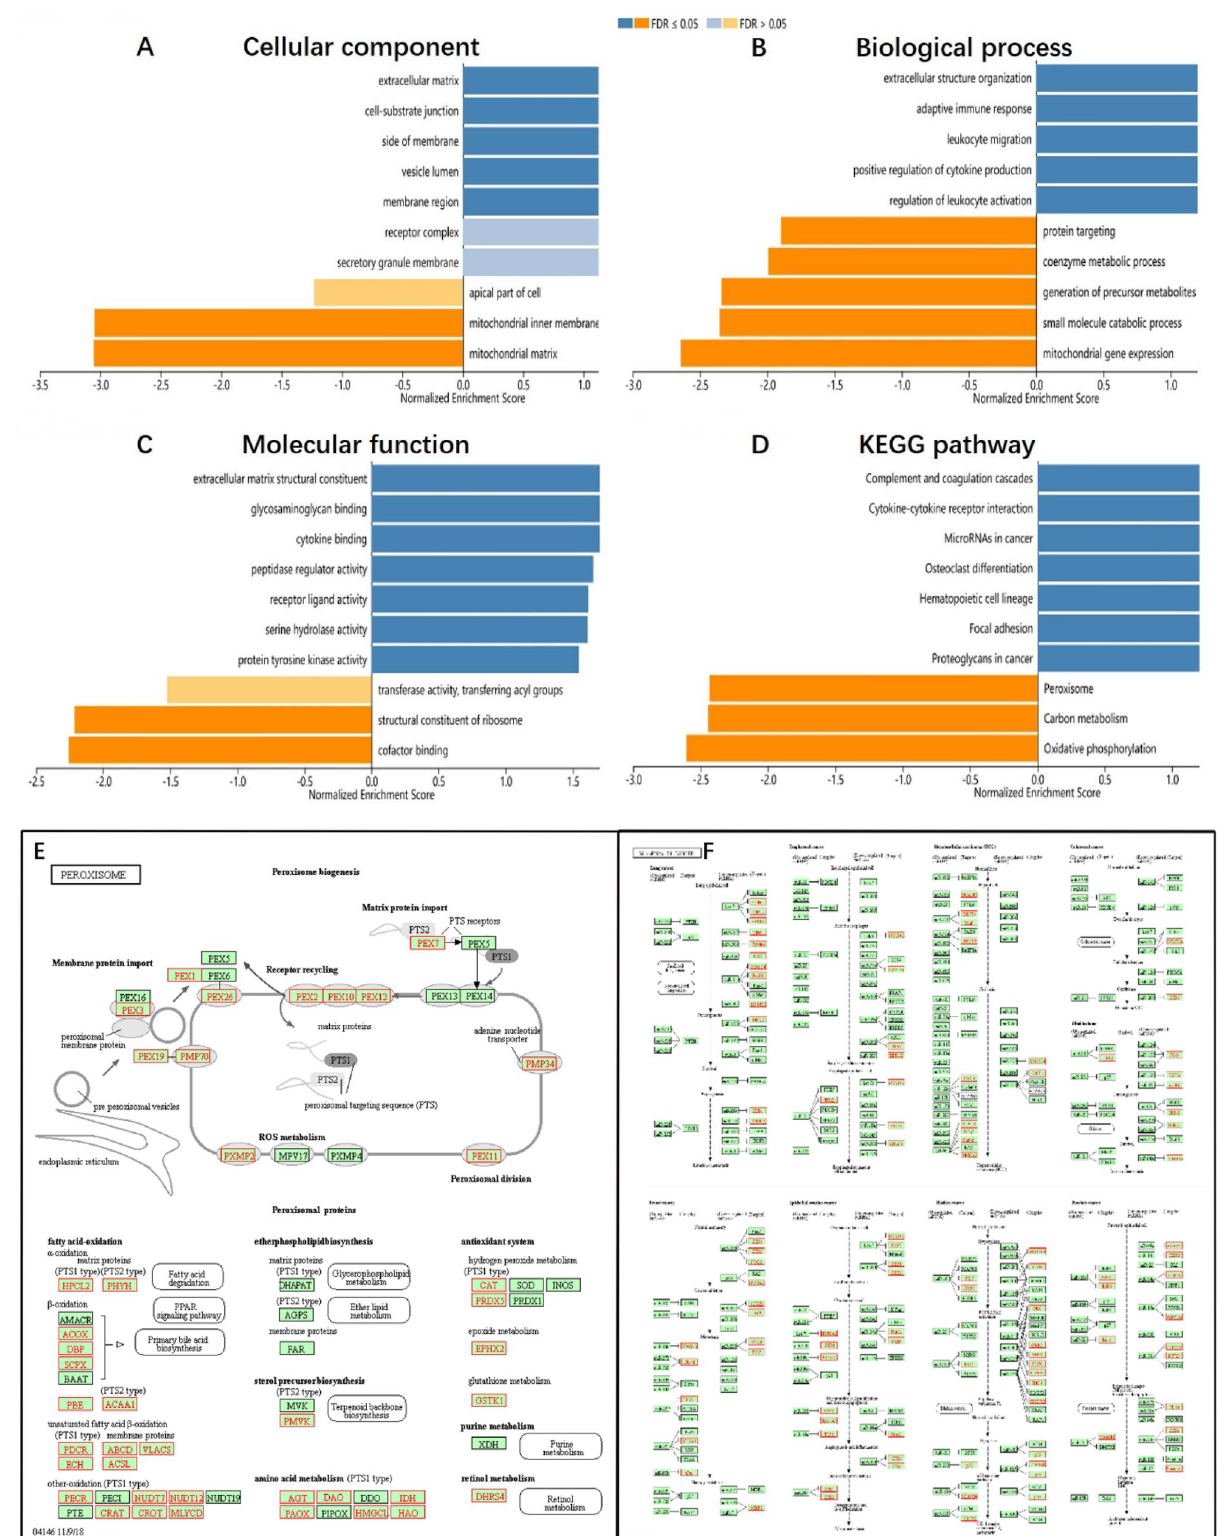
Figure 6. Significantly enriched GO annotations and KEGG pathways of RUNX1 in KIRC were analyzed using GSEA. ( A ) Cellular components. ( B ) Biological processes. ( C ) Molecular functions. ( D ) KEGG pathway analysis (www. kegg. jp/ kegg/ kegg1. html). KEGG pathway annotations of the cell cycle pathway. ( E ) Peroxisome biogenesis, ( F ) MicroRNAs in cancer. Red marked nodes are associated with the Leading Edge